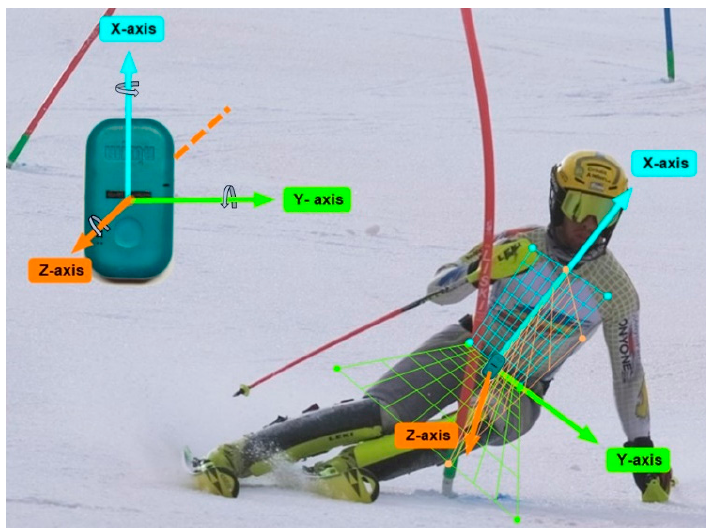
Figure 1. Measurement system and axis orientation. The X -axis (blue) is the vertical one, the Y -axis (green) is the lateral one, and the Z -axis (orange) is the antero-posterior one. Photo reproduced with permission from Diana Martin i Gamisans/Crèdit Andorrà Supporting and edited by the